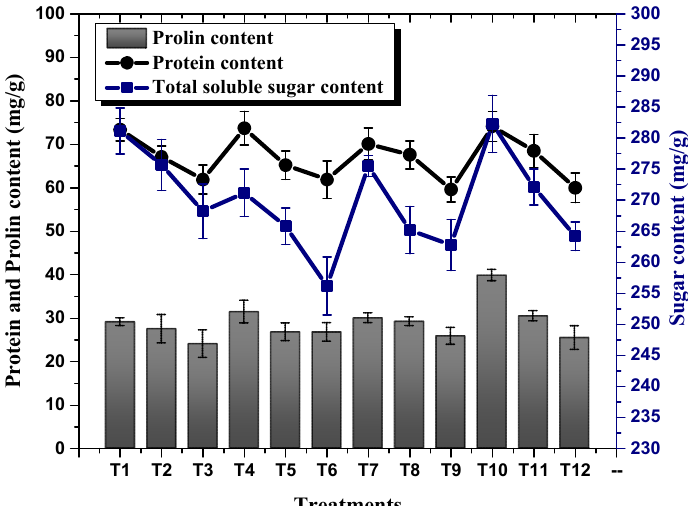
Figure 8. Effect of TU–ANPs on osmolytes content (protein, proline and soluble sugar) of Zea mays under various levels of NaCl-based osmotic stress.